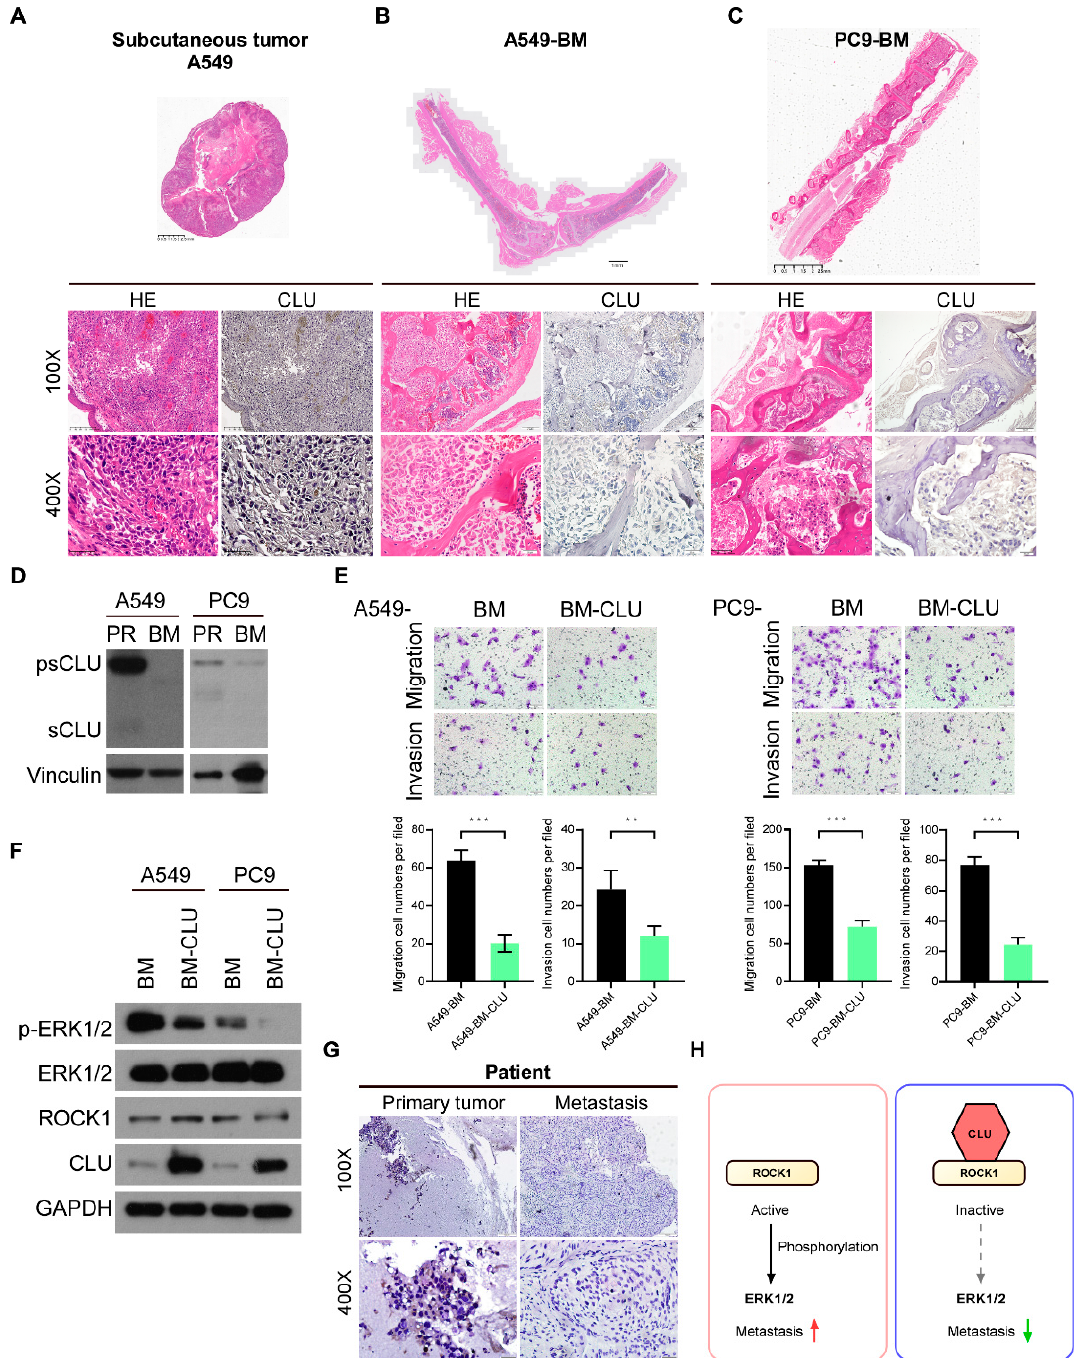
Figure 6. Precursor CLU is negatively related to metastasis in models and tumor tissues. ( A – C ) Representative images of H&E and IHC staining for CLU subcutaneous tumor lesions of A549 cells ( A ), bone metastases loci of A549-BM cells ( B ) and PC9-BM cells ( C ). ( D ) The expression of CLU in A549- and PC9-BM cells and parental (PR) cells. ( E ). The effect of silenced CLU in A549- and PC9-BM cells on their abilities of migration and invasion. ( F ) The effect of silenced CLU on the level of phosphor- ylation of ERK in A549- and PC9-BM cells. ( G ) Representative images of IHC staining for CLU in lung cancer primary and bone metastatic loci. ( H ) The mechanism through which CLU inhibits me- tastasis is via the ROCK1/ERK axis. Results are presented as mean ± SD, ** p < 0.01, *** p < 0.001, ns means no significance.